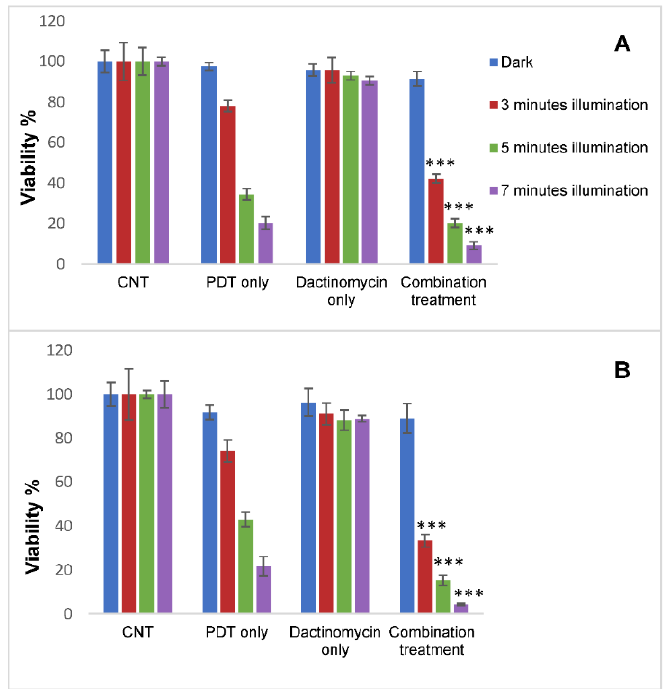
Figure 5. Percentage viabilities of SKOV3 ( A ) and HEY ( B ) cells in 3D compressed collagen constructs following PDT, dactinomycin only and combination treatments. The Constructs were treated with TPPS2a (0.3 µg/mL for SKOV3 cells) and (0.4 µg/mL for HEY cells), 1 nM dactinomycin and a combination of both drugs. The cultures were treated using a blue lamp at wavelength of 420 nm and light power of 7 mW/cm 2 . The total light doses used were 1.26 J/cm 2 (3 min), 2.1 J/cm 2 (5 min) and 2.94 J/cm 2 (7 min). The cultures were incubated for 48 h post illumination before terminating the experiment. The results were obtained using Alamar Blue assay. Statistical analysis was carried out using 2-way ANOVA. *** p < 0.001. The p values show the significance difference between PDT and combination treatments.